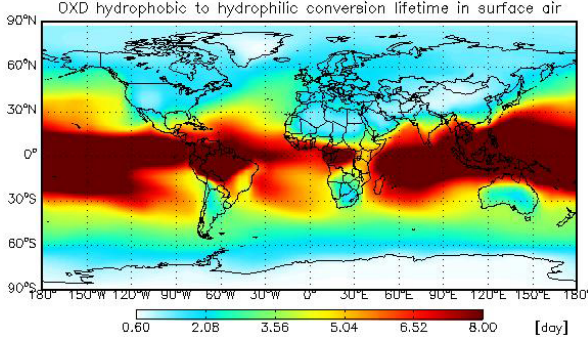
Fig. 2a. Model calculated hydrophobic to hydrophilic conversion lifetime for carbonaceous aerosols in surface air by oxidation aging scheme. OXD (hereinafter) represents oxidation aging scheme.